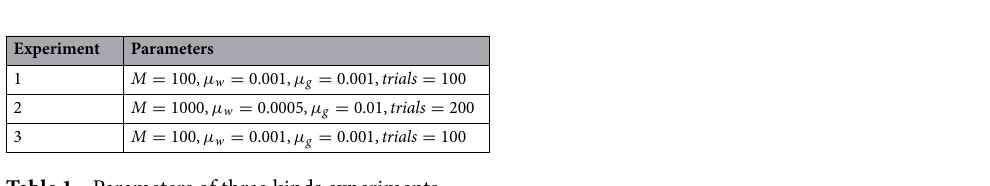
Table 1. Parameters of three kinds